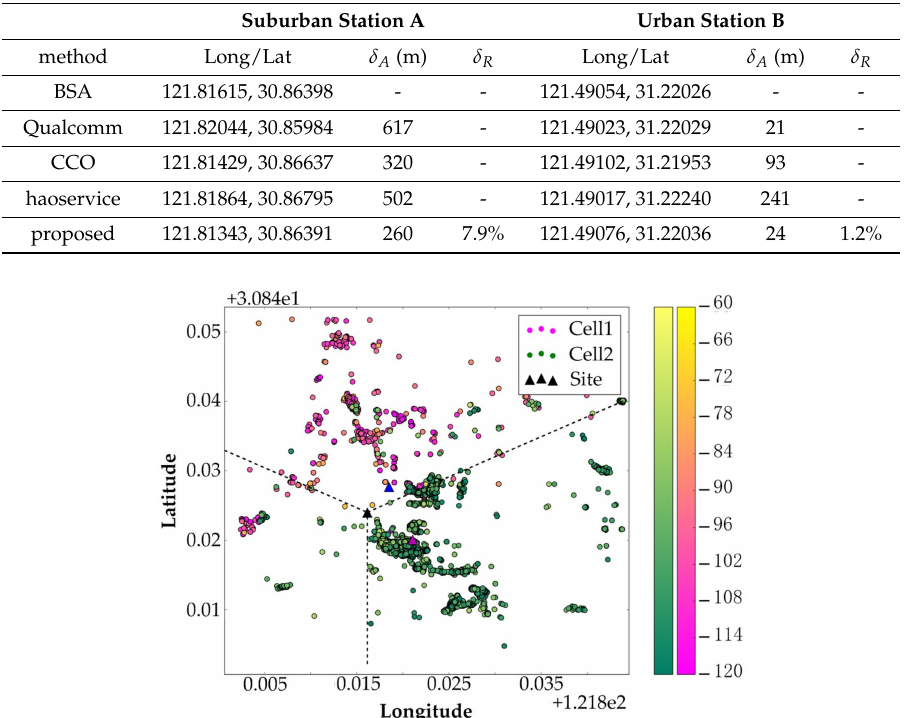
Table 3. Estimate Results of BS Location.